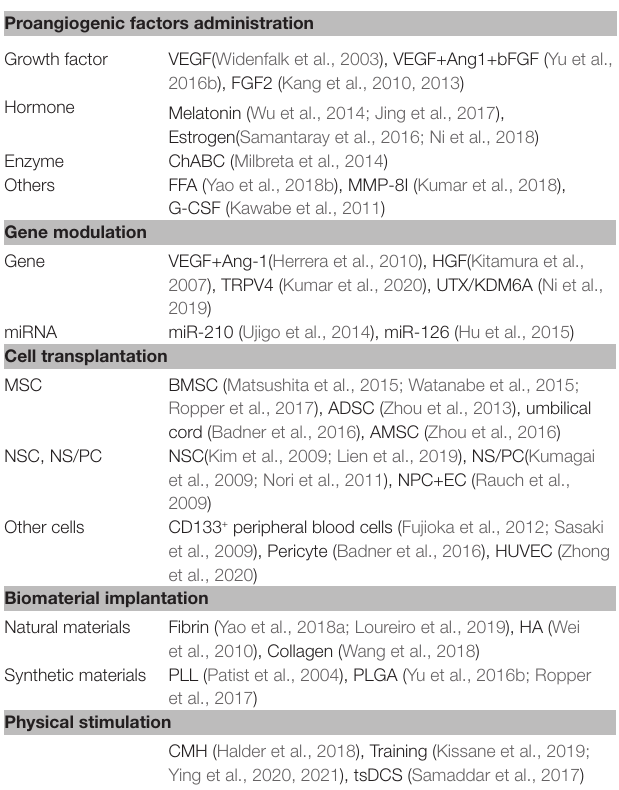
TABLE 1 | Lists of current blood vessel interventions for spinal cord